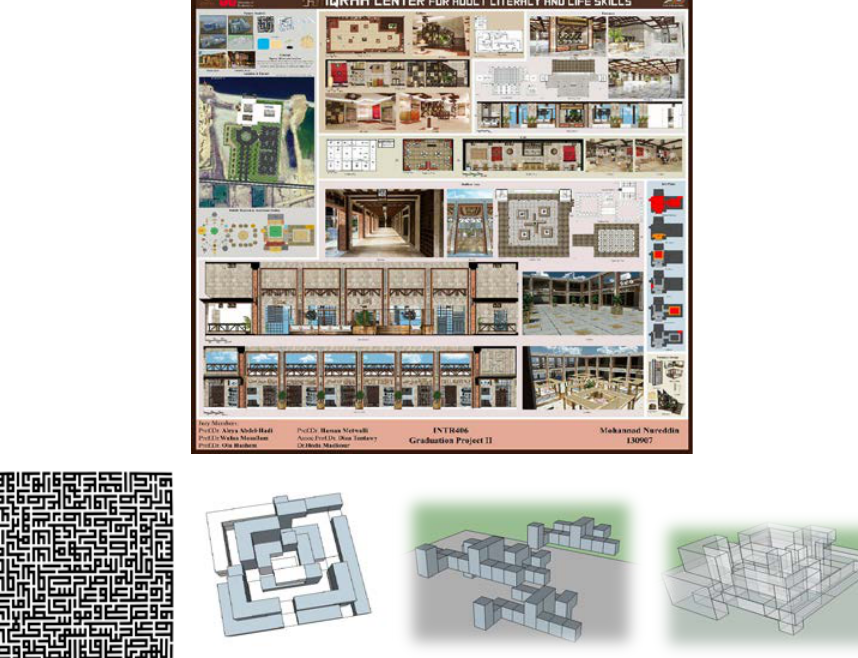
Figure (11): IQRAA Centre for Adults Literacy in Fayoum: the student has studied the location, citizens needs and designed a project that provides them with an educational and training services inspired by Arabic calligraphy patterns. Source: Interior design Department digital archive library of Grad. Projects.